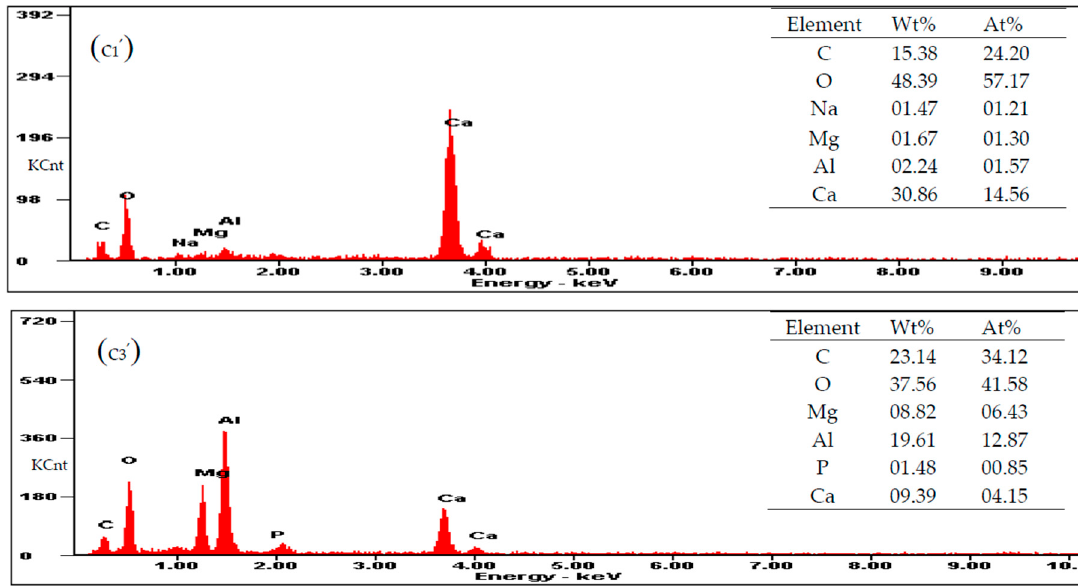
Figure 9. SEM and EDS images of the minerals in control and experimental groups at 15% NaCl and different Mg/Ca molar ratios in MgCl 2 solution after 15 days of cultivation: ( a 1 , a 2 ) Mg/Ca molar ratio of 0 in the control group; ( b 1 , b 2 ) Mg/Ca molar ratio of 2 in the control group; ( c 1 , c 2 ) Mg/Ca molar ratio of 4 in the control group; ( a 3 , a 4 ) Mg/Ca molar ratio of 0 in the experimental group; ( b 3 , b 4 ) Mg/Ca molar ratio of 2 in the experimental group; ( c 3 , c 4 ) Mg/Ca molar ratio of 4 in the experimental group;